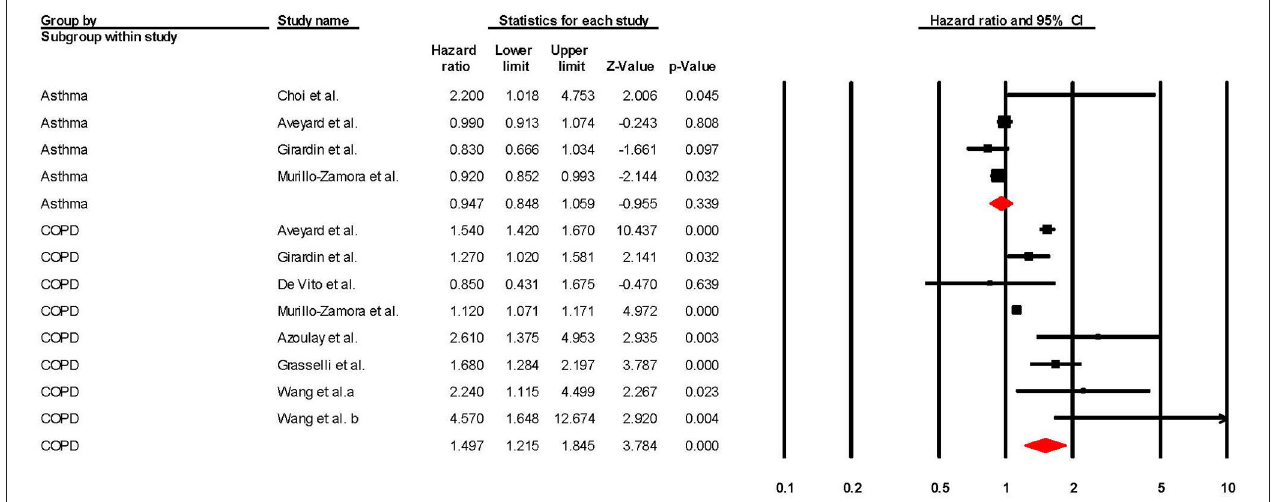
FIGURE 5 | Forest plot showing Cox regression hazard ratios (adjusted for at least one comorbidity) for COVID-19 related overall mortality in subjects with asthma or Chronic Obstructive Pulmonary Disease